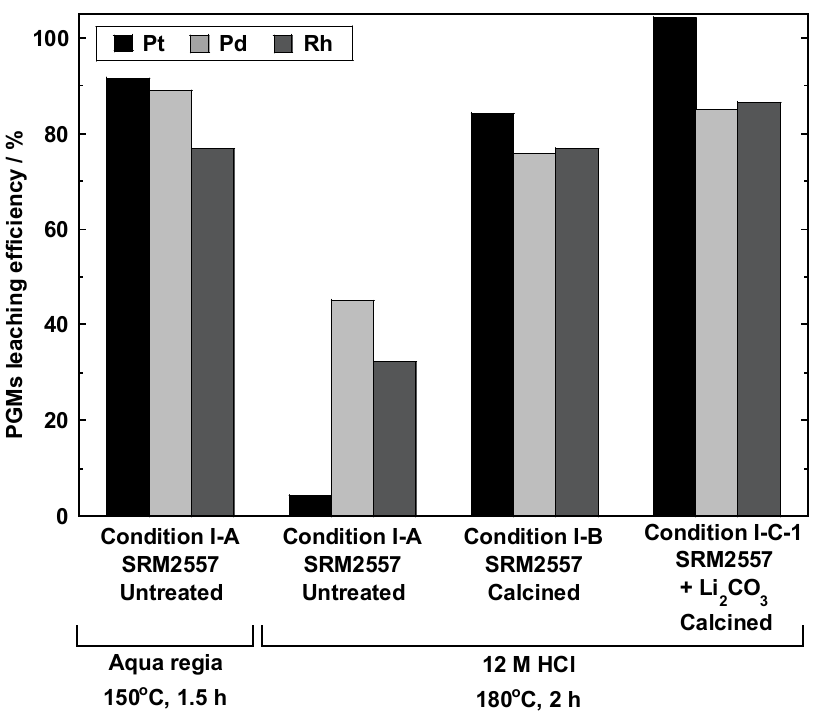
Figure 5. Pt, Pd, and Rh leaching efficiencies in the solutions obtained under conditions I-A, I-B, and I-C-1.